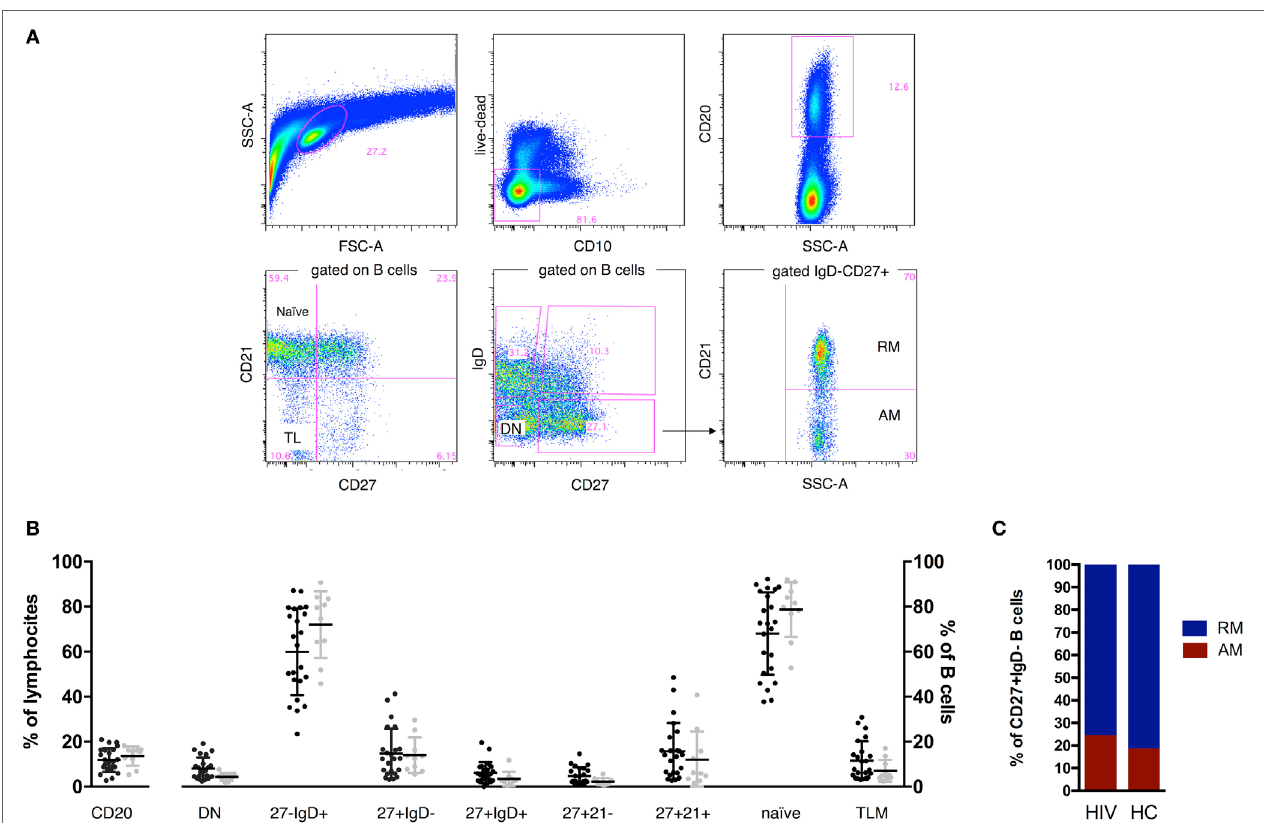
FigUre 1 | B cell phenotype in HIV and age-matched healthy control (HC). Representative gates (a) and comparisons of B cell percentages (B,c) . Two tailed Mann–Whitney was used for comparisons. CD20 + cells established the B cell population, and expression of IgD, CD27, CD21, and CD10 was used to define total naive (CD27 − IgD + ), class switched CD27 + memory B cells (CD27 + IgD − ), double-negative (DN; CD27 − IgD − ), resting memory (RM), tissue-like (TL), activated memory (AM), and naive. FSC, forward scatter; SSC, side scatter. Contingency plot in (c) represents frequency of AM and RM in HIV and